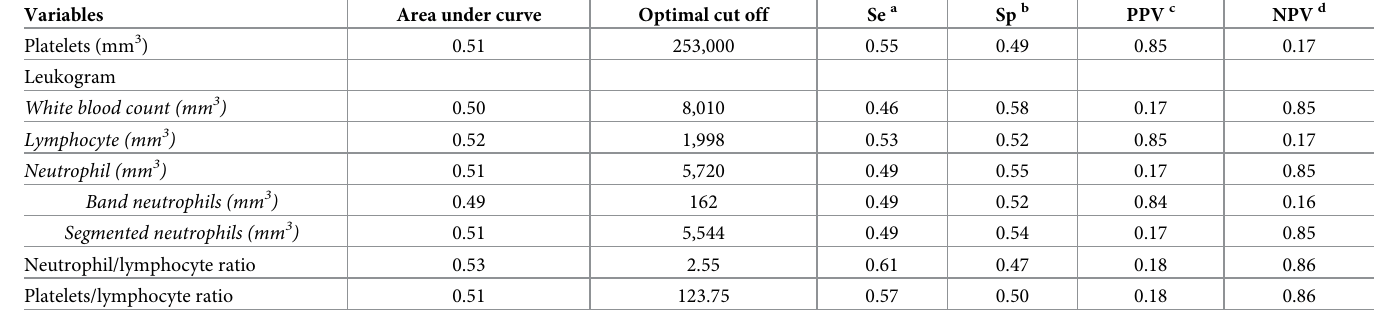
Table 3. Predictive variables of the occurrence of gestational trophoblastic neoplasia among patients with complete hydatidiform mole obtained by receiver operat- ing characteristic curves. Variables